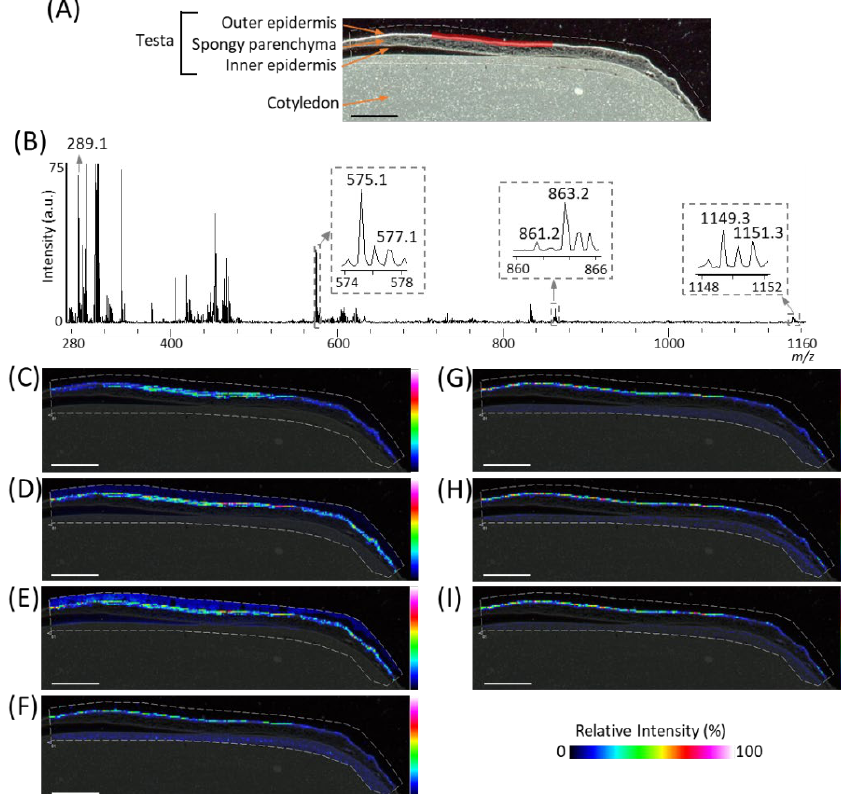
Figure 3. Matrix assisted laser desorption/ionization (MALDI)-mass spectrometry imaging (MSI) analysis of the outer epidermis of the peanut testa. ( A ) Optical image of the peanut longitudinal section before MALDI-MSI analysis. This is the same optimal image shown in Figure 2A. ( B ) Mass spectrum extracted from the outer epidermis of the peanut testa is indicated by the region filled in red in Figure